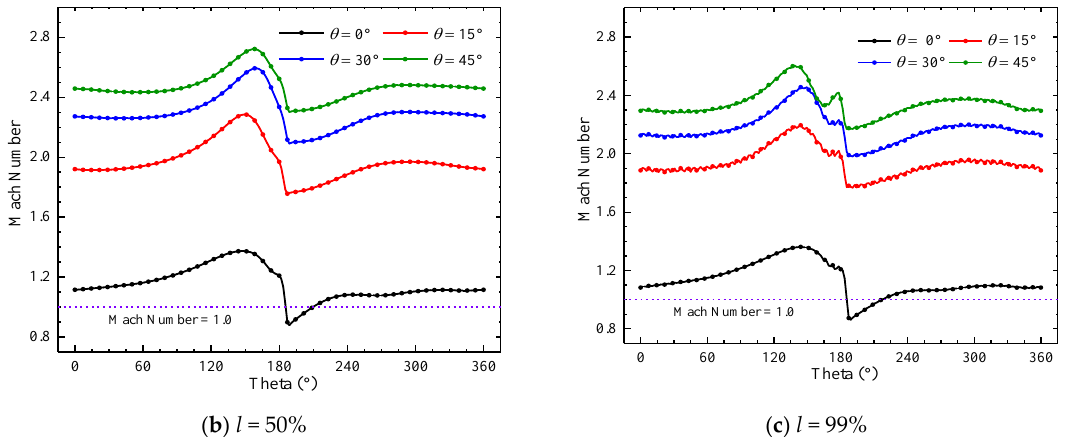
Figure 23. The circumferential outlet Mach number distribution of the RDC at t = 3980 μs.